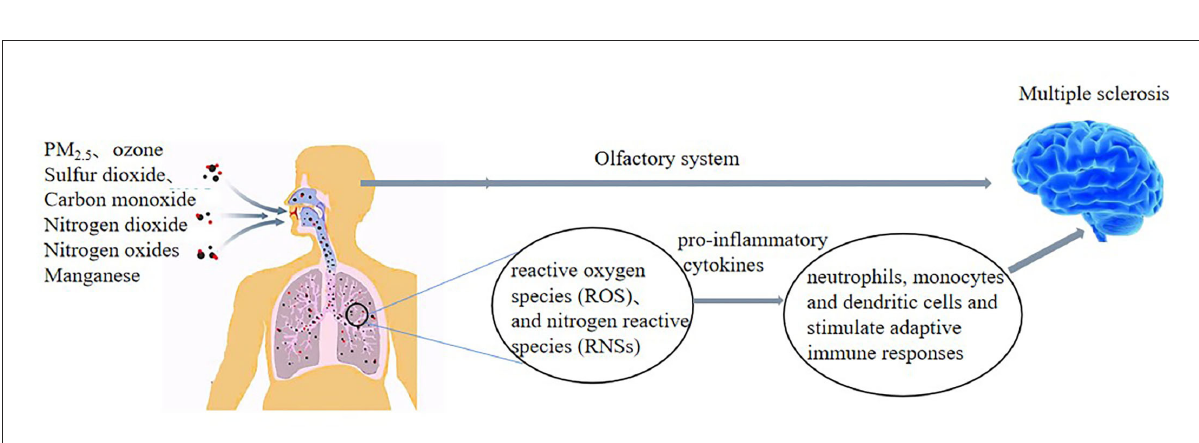
neurodegenerative changes, including neuronal apoptosis and reductions in synaptic structural and functional proteins